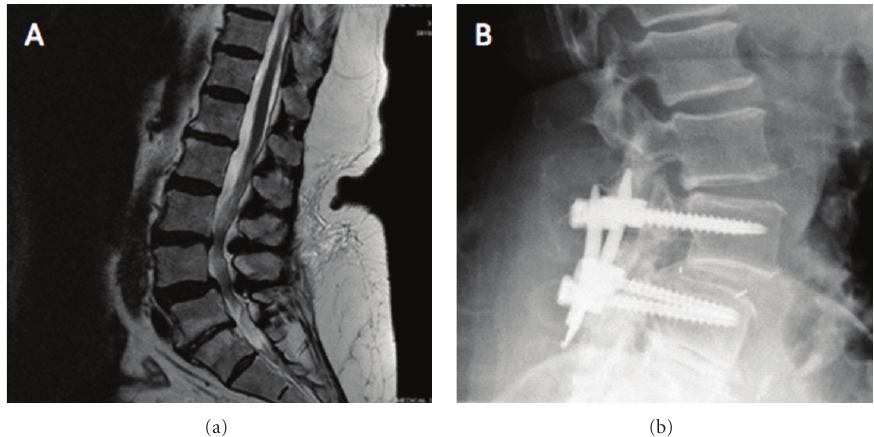
Figure 1: (a) Preoperative lateral MR image of a 72 y/o female patient with back and left leg pain and L4/L5 spondylolisthesis; (b) post- operative lateral MR image from a patient who underwent an MI-TLIF for spondylolisthesis at L4/L5.